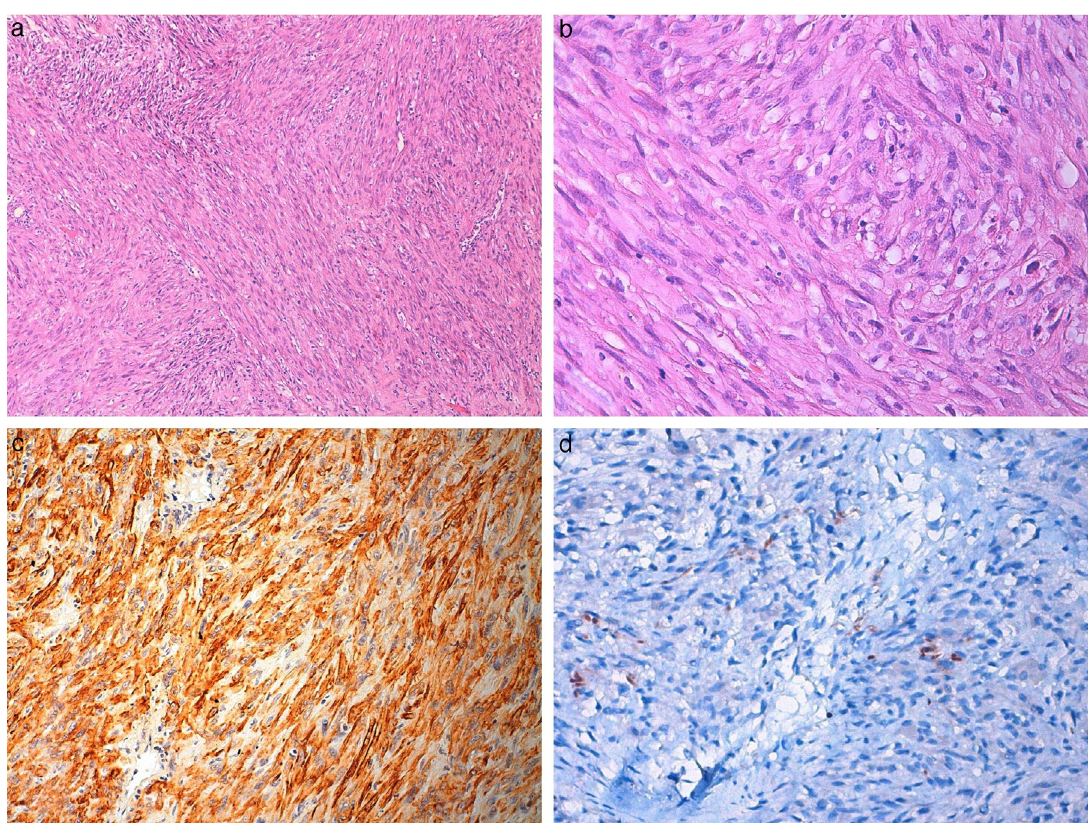
Figure 3 (a, b) Photomicrograph of Case 1, showing spindle cell tumor arranged in fascicular pattern with eosinophilic cytoplasm (hematoxylin and eosin × 100, × 400). (c) Tumor cells showing diffuse actin positivity ( × 200) and (d) focal desmin positivity ( × 400). markers including pan-cytokeratin, thyroglobulin, and TTF-1 were negative (Fig.